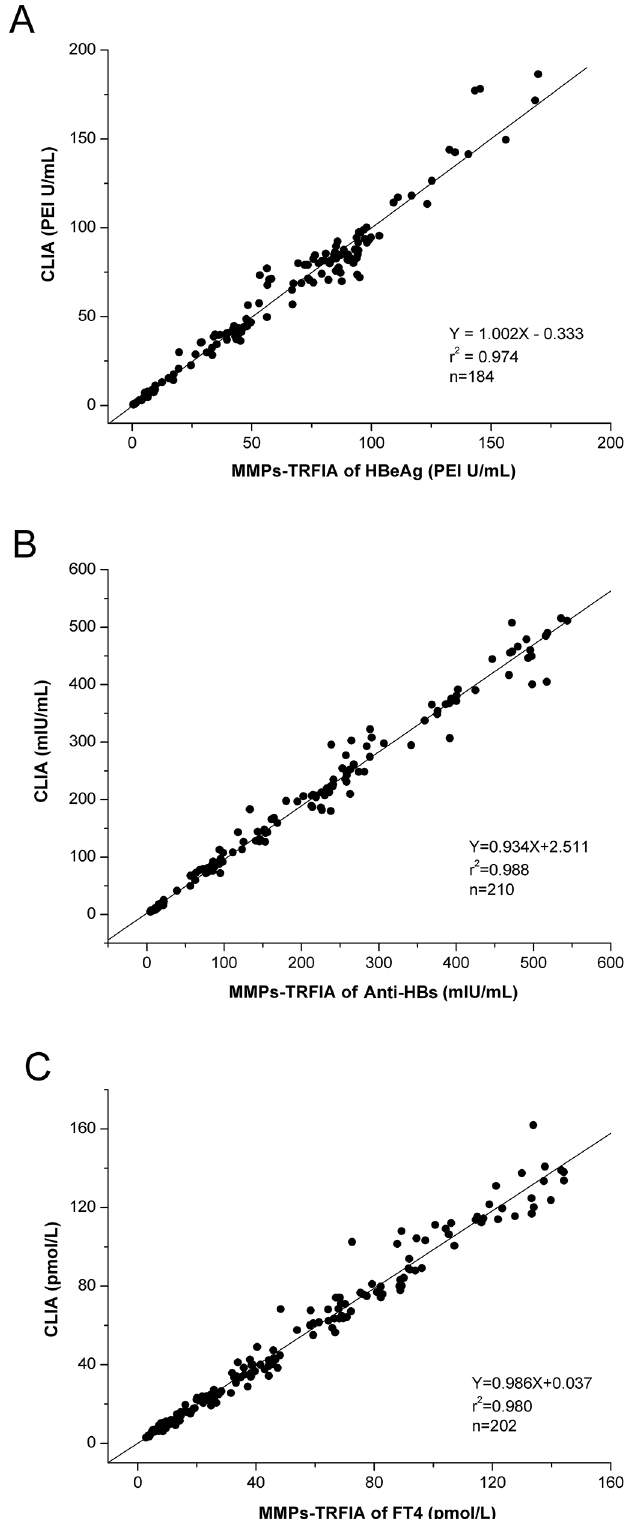
Fig 4. Plot of the results obtained with the proposed method versus those obtained using CLIA for 184 positive HBeAg samples (A), 210 positive anti-HBs samples (B) and 202 FT4 samples(C).